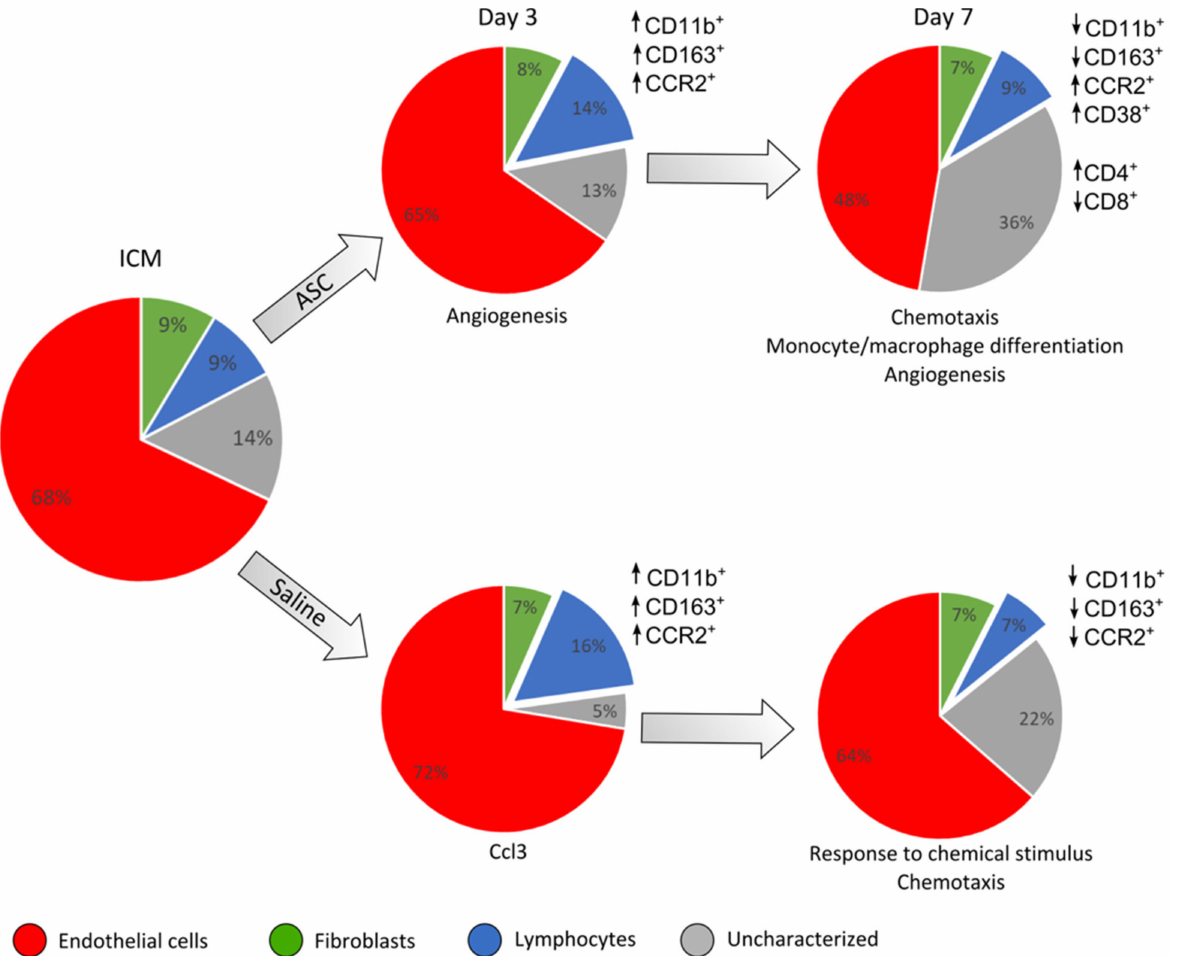
Figure 7. Summary of the findings of changes in cardiac cell composition and peri-infarct transcription. This is based on the results depicted in previous figures. The cell populations based on CD45, CD31, and CD90 are depicted in pie charts for each group and day after treatment. The response in CD45+ cell subpopulations compared to ICM is depicted for the different markers besides the charts. The interpretation of transcriptional results from the peri-infarct region is noted below the charts. ↑ refers to an increased percentage of the given cell population and ↓ a decreased